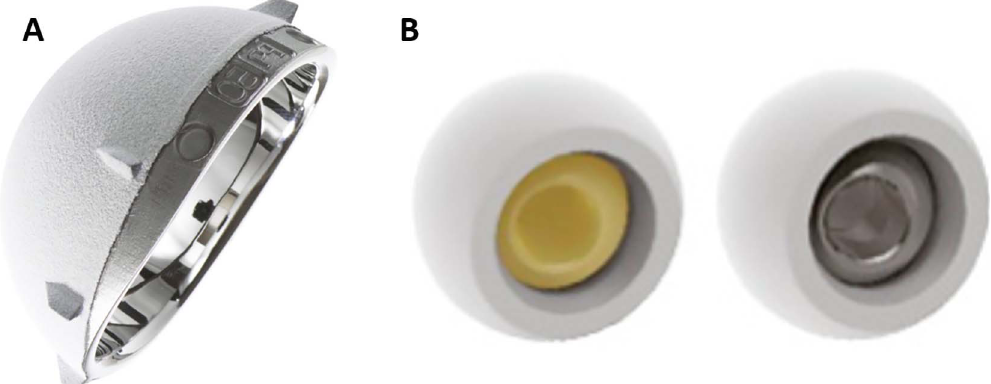
Figure 1. Quattro (cid:3) cup, hemispherical cup with partially extended rim for additional joint stability (a). Pre-impacted head and liner, this solution, in addition to saving operative time, handling and storage, makes it possible to secure the impaction which is done perfectly in the axis in a robotized way and thus protects the third articulation, in particular, the head capture mechanism